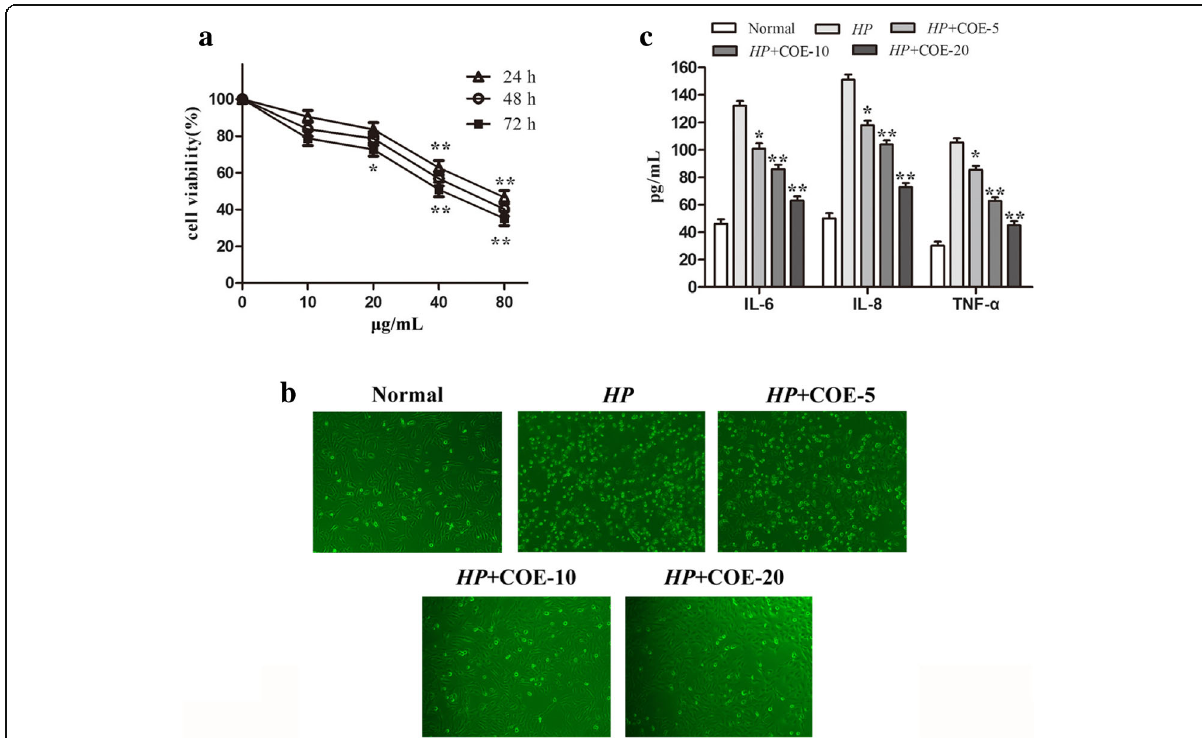
Fig. 1 Effect of COE on H. pylori infection-induced cell morphological and inflammatory cytokine changes . ( a ) The effects of COE toxicity on cell viability of GES-1 cells after 24, 48, 72 h culture. The cell viability showed the results of three separate experiments as mean ± SD, * P < 0.05, ** P < 0.01, vs 0 μ g/mL. ( b ) The effects of COE on H. pylori -infected cell morphological changes. Representative pictures of cells were obtained under a microscope at × 200 magnification. ( c ) The effects of COE on H. pylori -induced pro-inflammatory cytokine changes. ELISA was applied to test the levels of IL-6, IL-8 and TNF- α . Data are presented as mean ± SD of three separate experiments, * P < 0.05, ** P < 0.01 compared with the H. pylori -infected